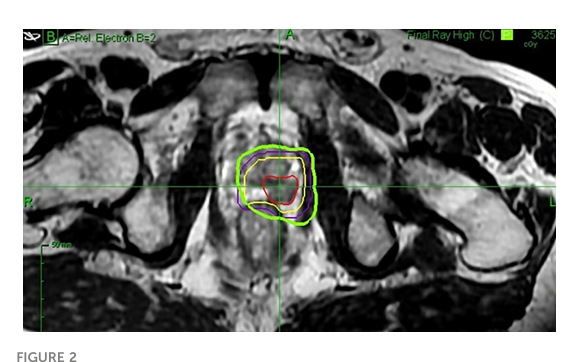
FIGURE 2 Example of a delineated focused stereotactic treatment on the MRI T2 sequence axial view. Red = gross target volume. Yellow = clinical target volume. Purple = planning target volume. Green = 36.25 Gy